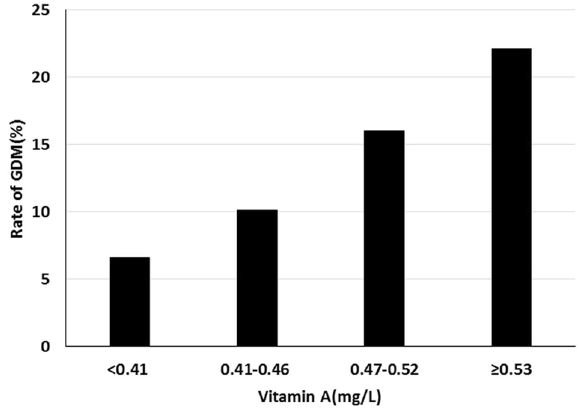
Fig. 2 Association of maternal vitamin A levels in early pregnancy with GDM. GDM gestational diabetes mellitus.